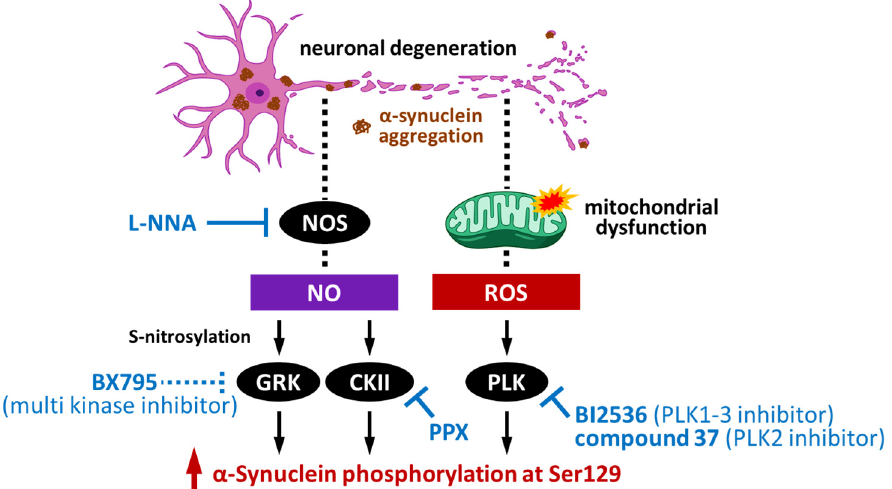
Figure 4. Schematic pathways of α -synuclein phosphorylation by kinases in the neurodegeneration process and potential pharmacotherapeutic targets [56,104,106–110]. NO: nitric oxide; NOS: NO synthase; ROS: reactive oxygen species; L-NNA: N(omega)-nitro-L-arginine, a competitive inhibitor of nitric oxide synthase; GRK: G-protein-coupled receptor kinase; CKII: casein kinase II; PLK: polo-like kinase; PPX: pramipexole.